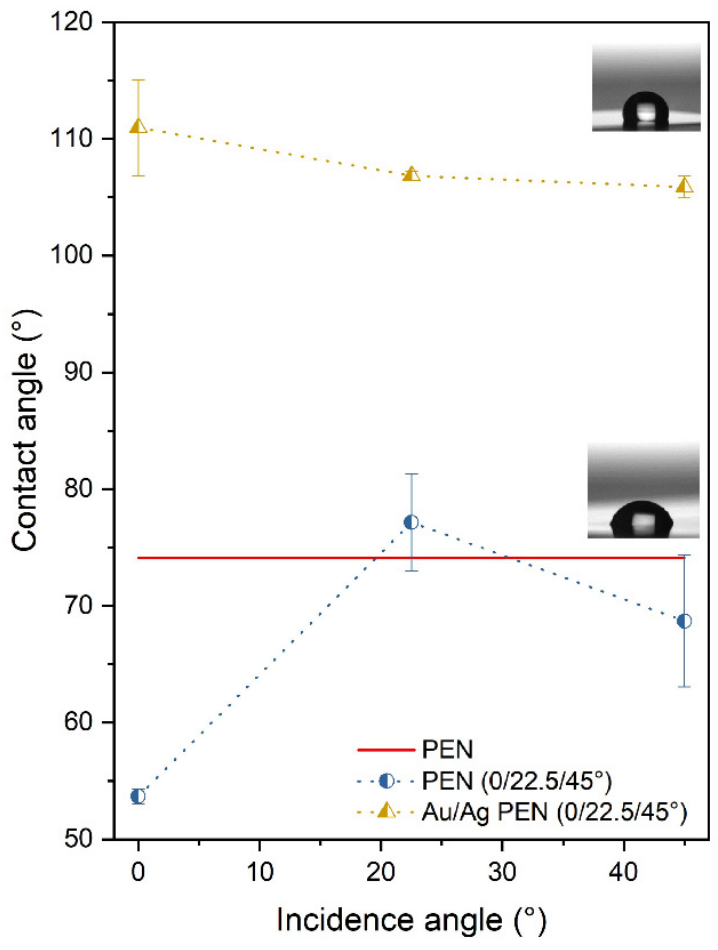
Figure 7. Contact angles of PEN, PEN 0/22.5/45° and Au/Ag PEN 0/22.5/45° samples.